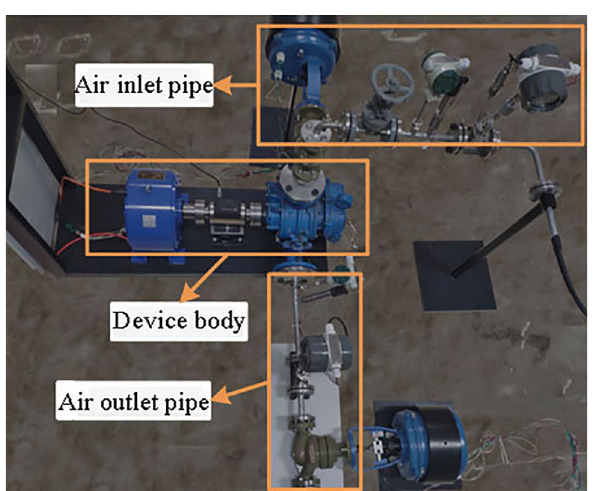
Figure 8. The overall structure of the experimental